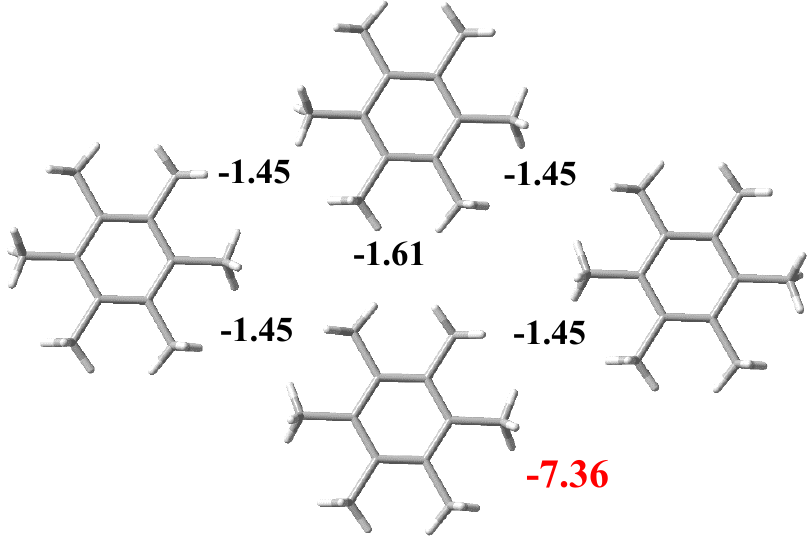
Figure 6. The four HMB molecules involved in a dispersion-bonded loop. The black numbers (in kcal/mol) are the interaction energies of two neighboring molecules, and the red number (in kcal/mol) is the total interaction energy of the tetramer.